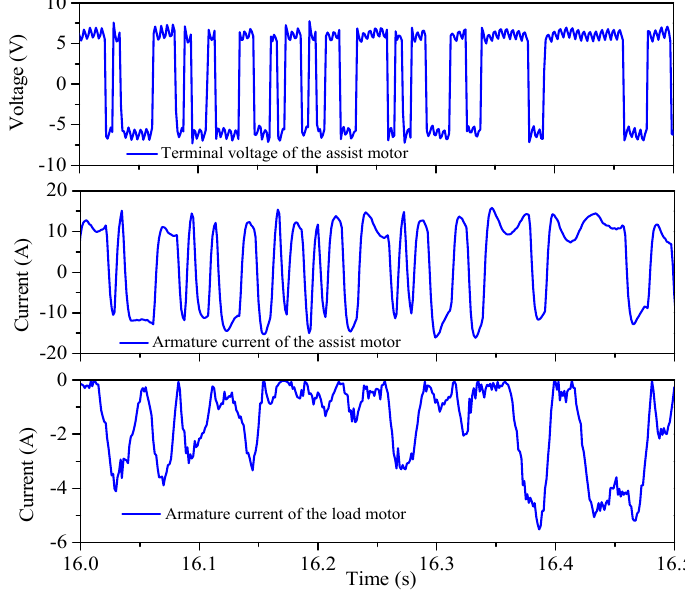
Figure 12. Time profiles of the assist motor current and voltage.